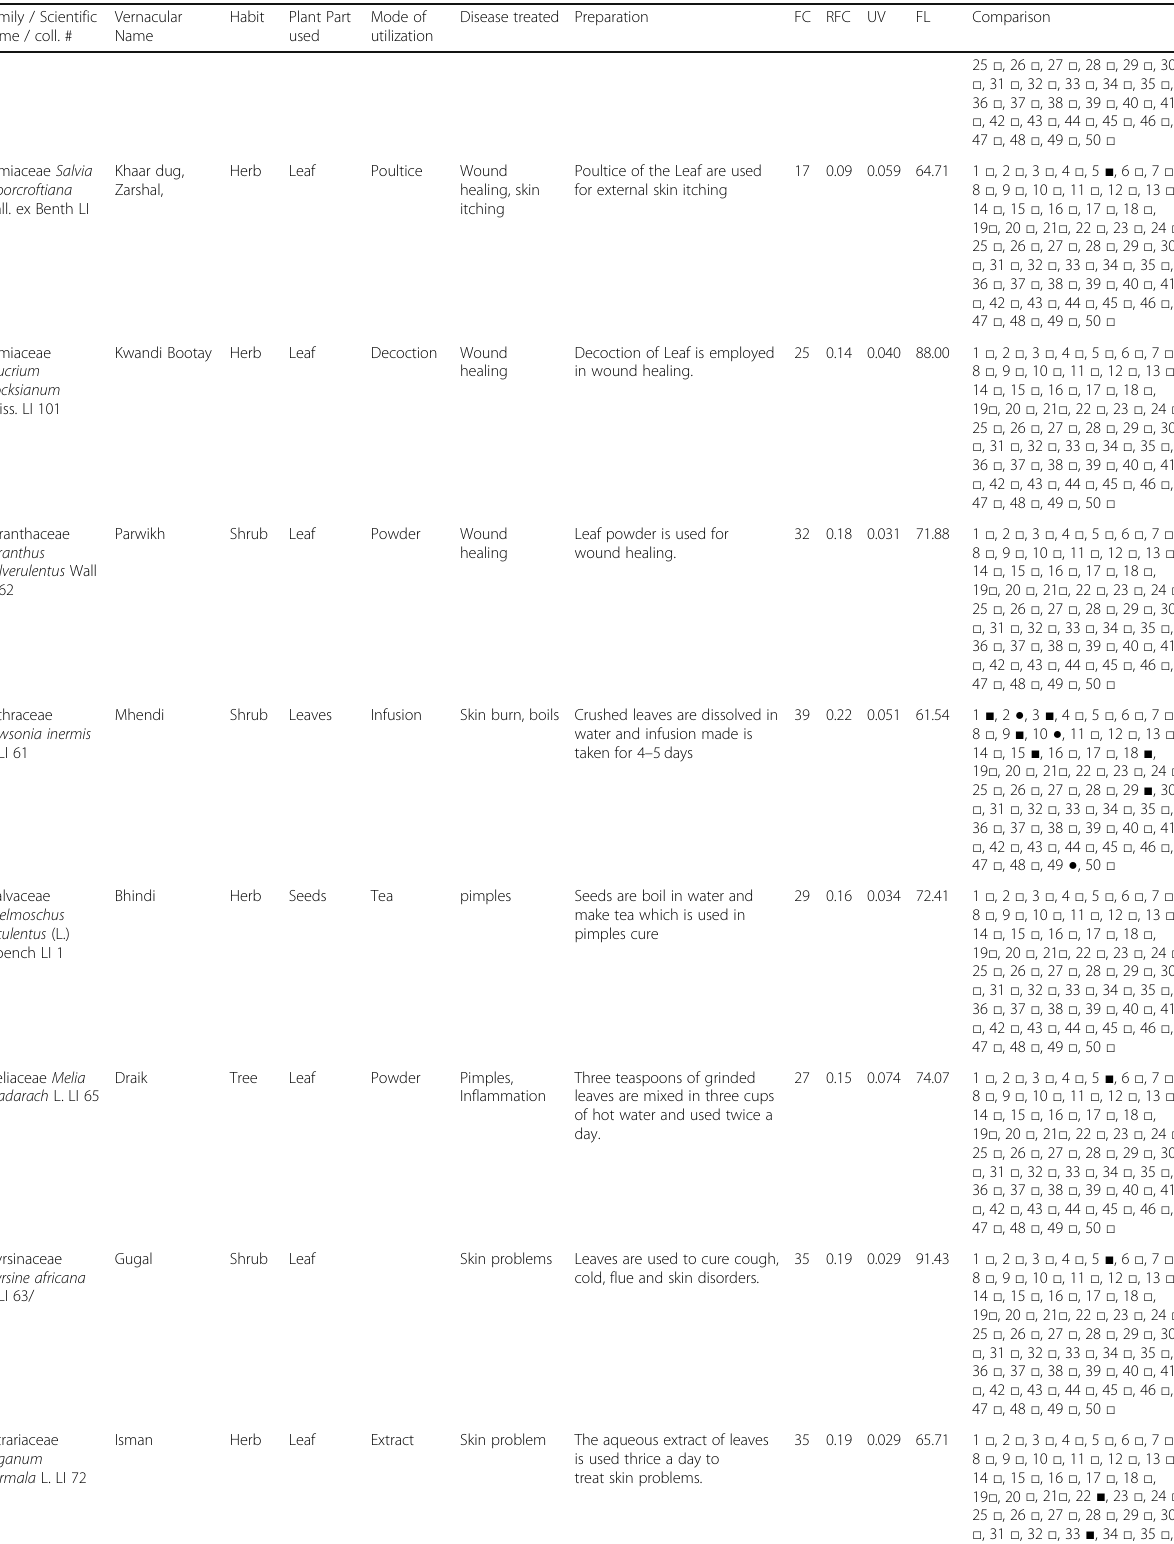
Table 2 Medicinal plants used for skin diseases in Northern Pakistan (Continued) Family / Scientific name / coll.